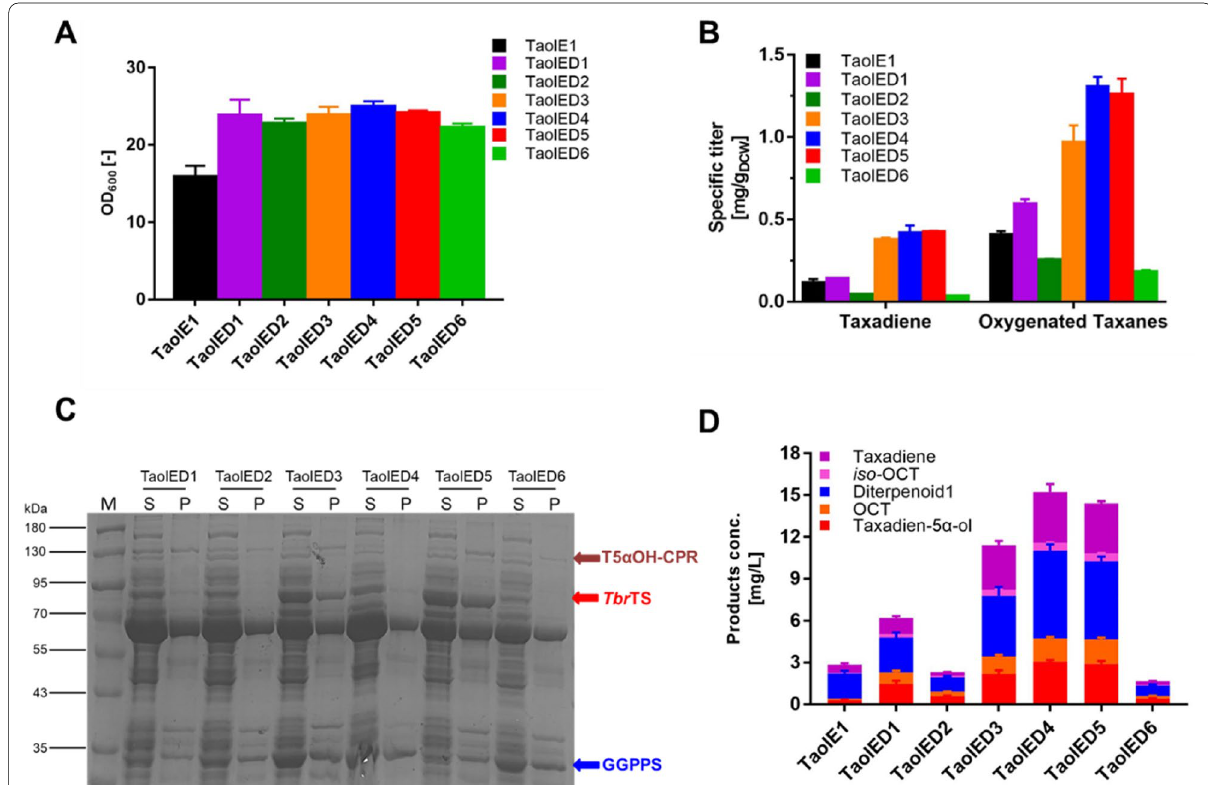
Fig. 2 Effects of bacterial metabolic burden on the yield of oxygenated taxanes. A Comparison of the OD 600 values of TaolED1‑6 strains at 48 h; B comparison of the specific titers of TaolED1‑6 strains; C SDS‑PAGE analysis of the protein expression levels of TaolED1‑6 strains; D comparison of the product concentrations of TaolED1‑6 strains. M: marker; S: supernatant; P: